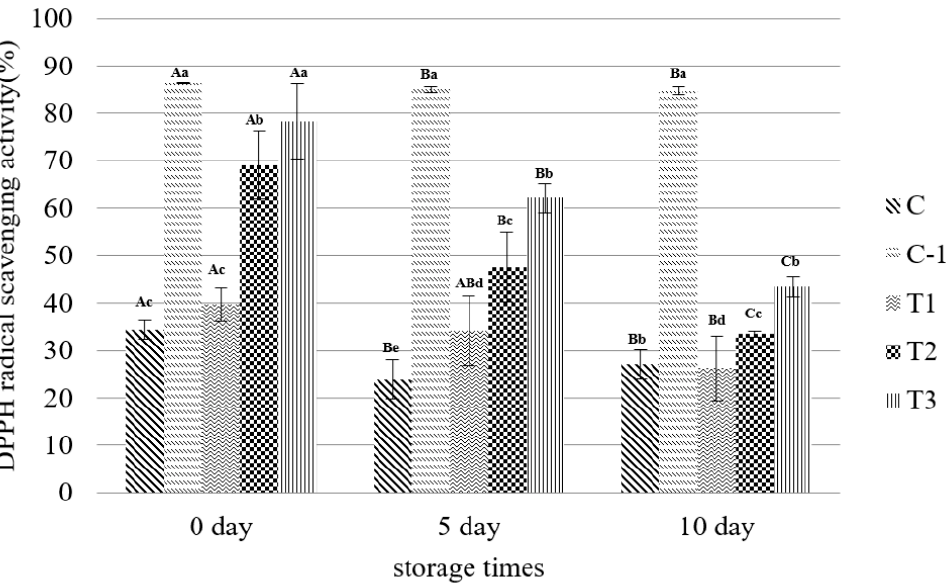
Figure 1. Antioxidant activity (%DPPH) of patties with different levels of soy sauce during 10 days of storage. A–C Least square means with different letters within the same day of storage time are significantly different ( p < 0.05). a–e Least square means with different letters within the same treatments are significantly different ( p < 0.05).